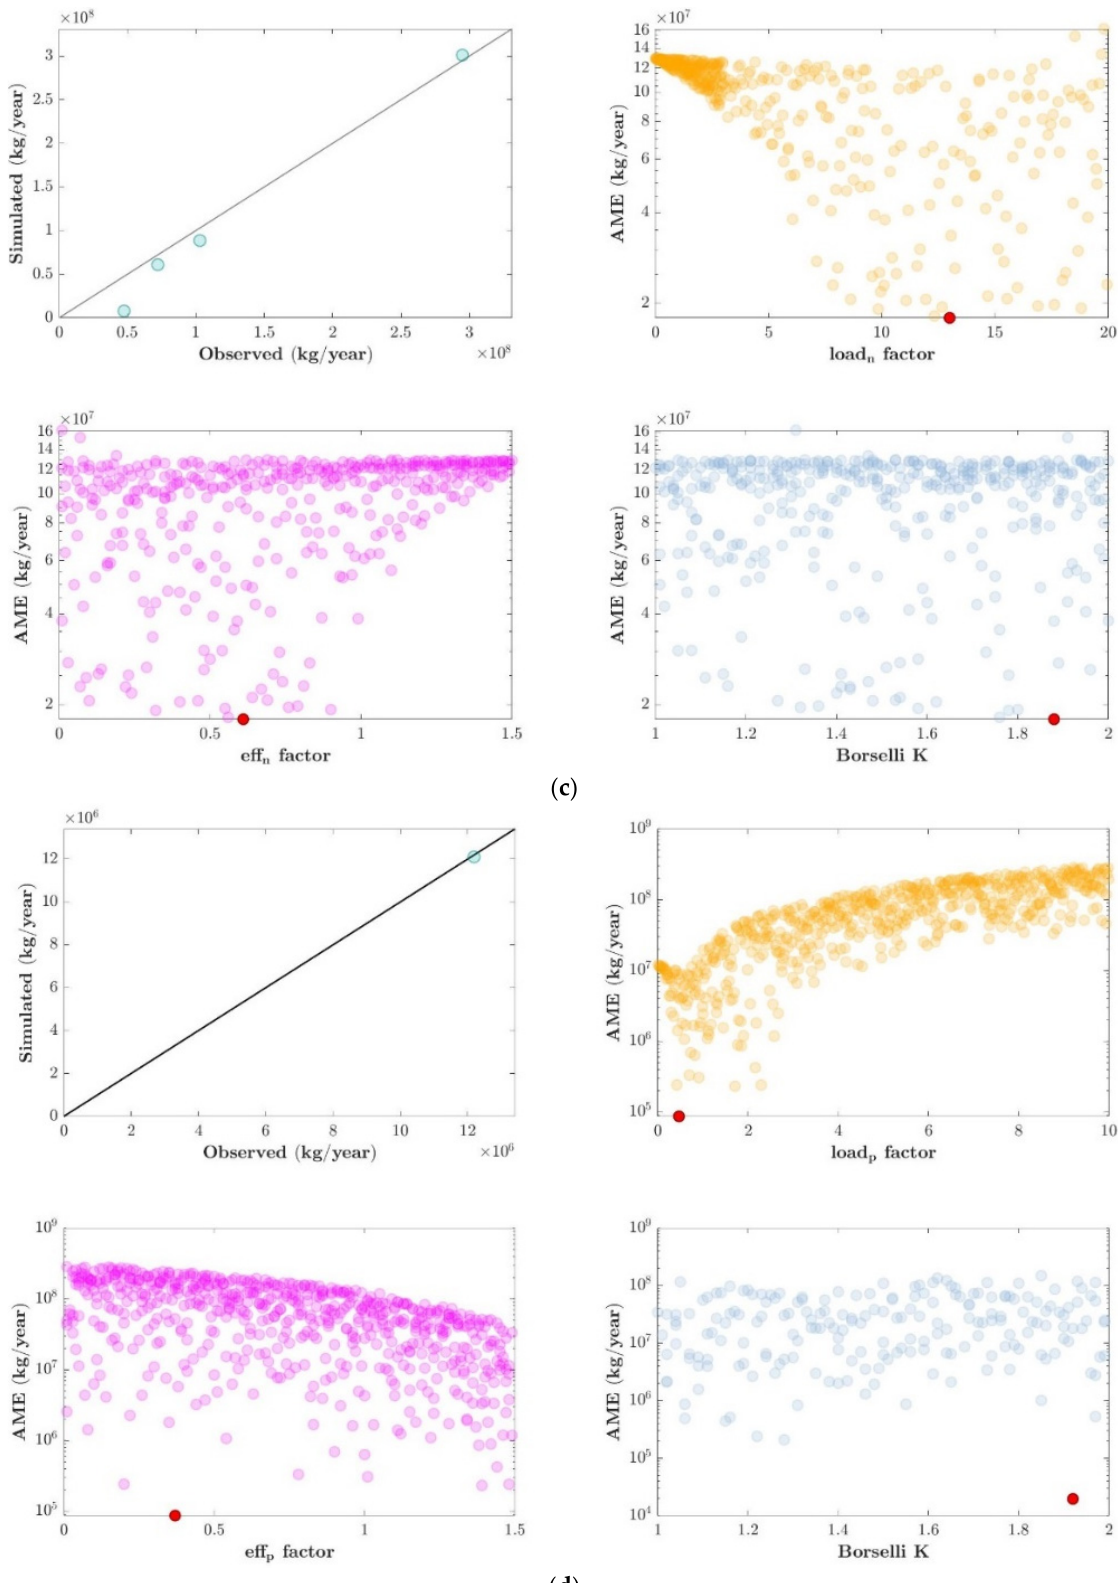
Figure 4. Examples of parametric consistency analysis results. ( a ) Model: AWY, Macro-Area: AF_1, Continent: Africa; ( b ) Model: SDR, Macro-Area: NA_1, Continent: North America; ( c ) Model: NDR-N, Macro-Area: EU_3, Continent: Europe; ( d ) Model: NDR-P, Macro-Area: SA_1, Continent: South America.